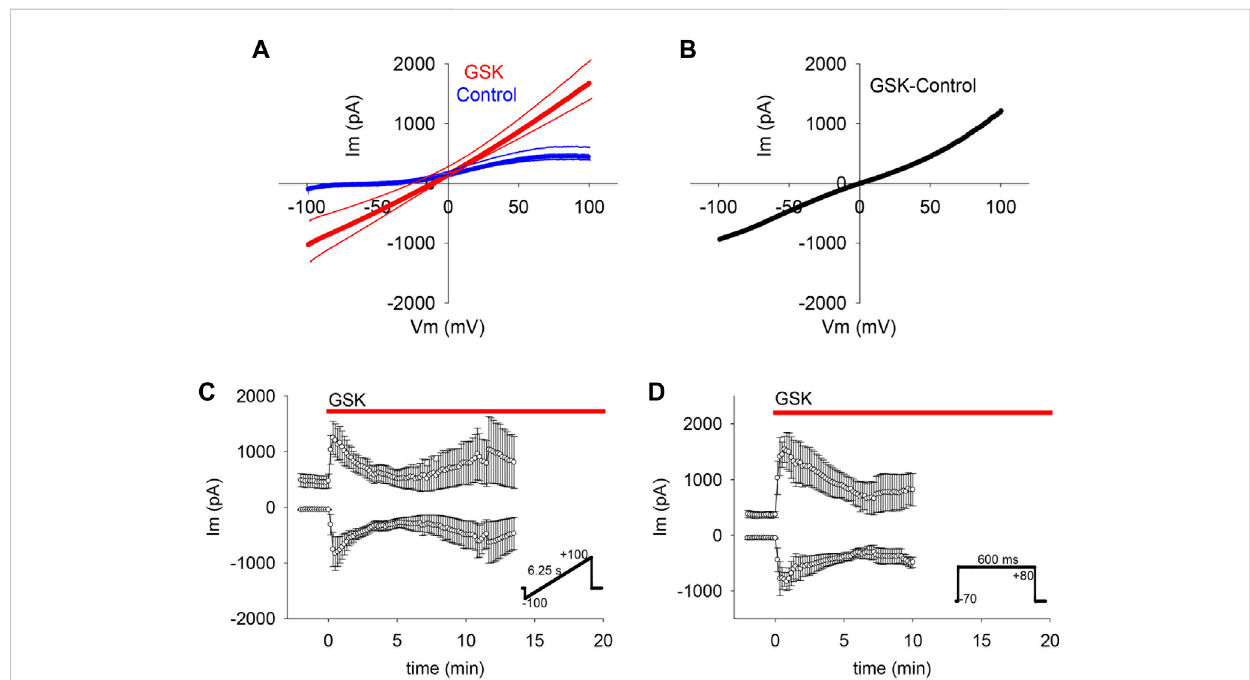
FIGURE 2 TRPV4agonistGSK1016790A(GSK)increasedgmonawidevoltagerange. (A – C) Voltageramps(insetinC)showedthatTRPV4activation increased WC Im in the range between − 100 and + 100 mV (A, average of n = 7); for clarity, SEM is shown as thin lines accompanying each curve). The net effect of TRPV4 activation on gm was evinced by subtracting the control from the GSK treated curve (B). The mean WC Im between − 100 and − 60, and between +60 and +100 mV plotted in time show the persistent gm changes (C, average of n = 7). (D) Square pulses (inset) con fi rmed the TRPV4 associated WC Im increases at − 70 and +80 mV ( n =